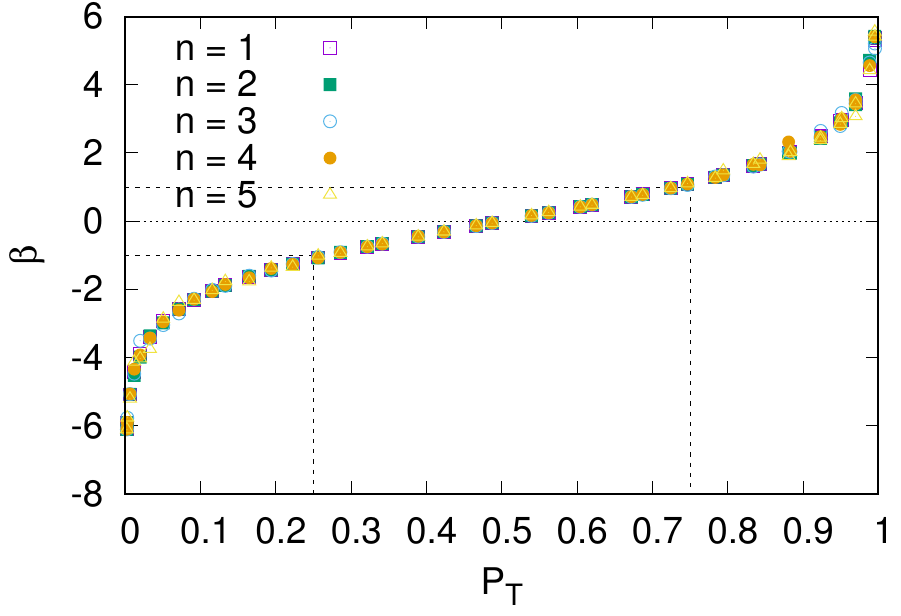
Figure 4. Slopes behavior obtained from the Power Spectrum analysis ( β ) as function of the trans- mission probability for different basis (n), β ≈ − 1, + 1 corresponds to P ≈ 0.25,0.75, respectively, for quantum chaos behavior. Clearly, β ≈ 0 corresponds to P ≈ 1/2, the quantum random, or wave- like behavior.